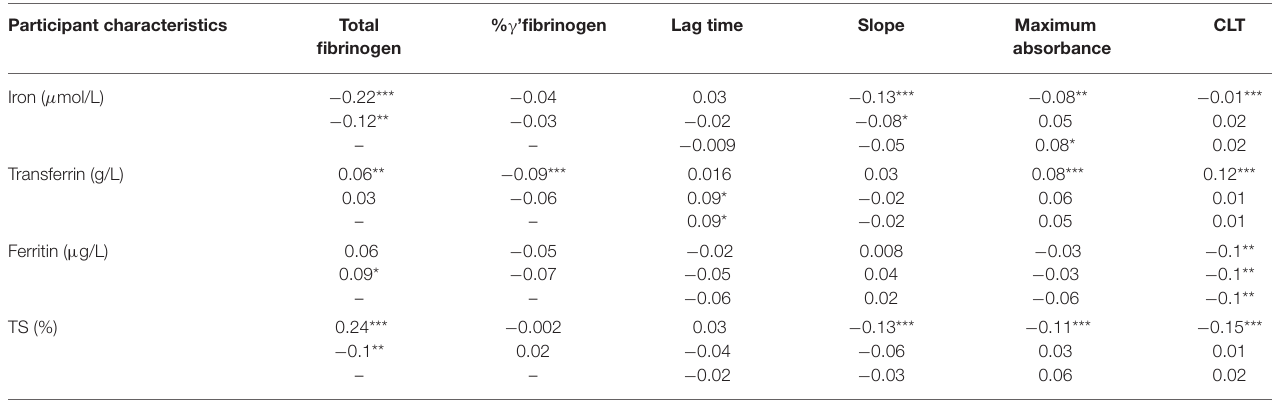
TABLE 2 | Correlations (r) of biomarkers of iron status with total fibrinogen and γ ’ fibrinogen concentrations and clot properties. Participant